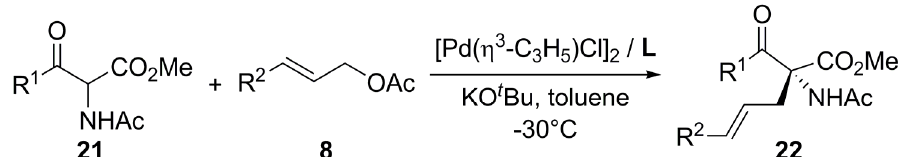
Table 4. Asymmetric allylation of  -acetamido-  -ketoesters.